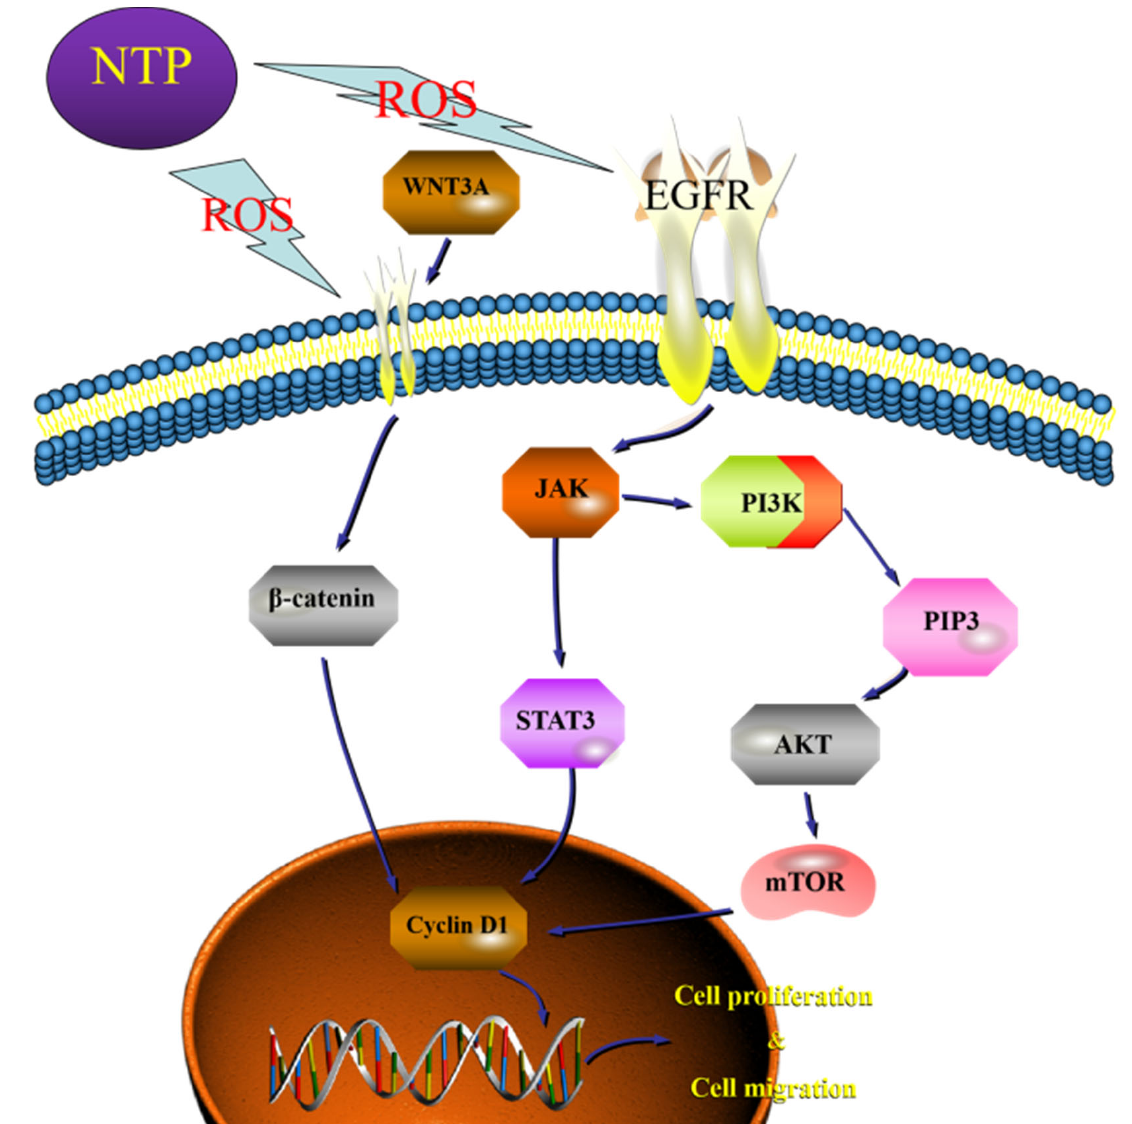
Figure 9. Effect of Wnt/ β ‐ catenin pathway inhibitor IWP ‐ 2 on HaCaT cell migration and effect of NAC on protein phosphorylation. ( A ) Picture of effects of IWP ‐ 2, a Wnt/ β ‐ catenin pathway inhib ‐ itor, on HaCaT cell migration. ( B ) Count of the number of migrated cells. ( C ) Effect of NAC on protein phosphorylation. ( D ) Quantification of phosphorylated protein expression. Data represent the mean ± SD of three independent experiments. * p < 0.05, ** p < 0.01, *** p < 0.001with ANOVA compared with the control.